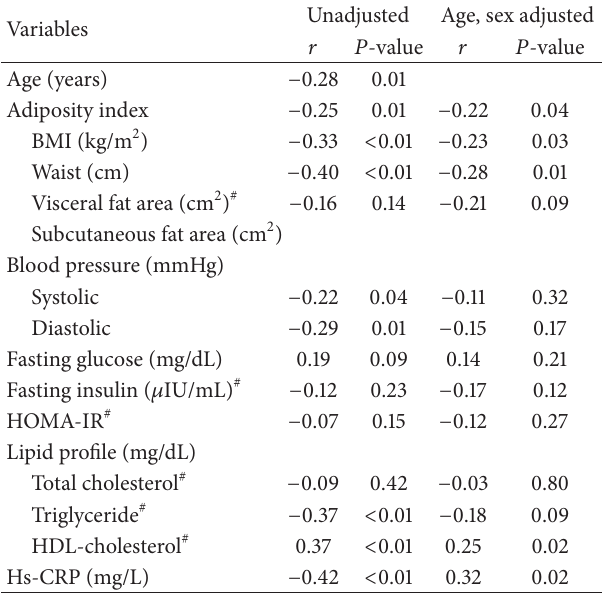
Table 2: The correlation between mtDNA copy numbers # and various parameters.